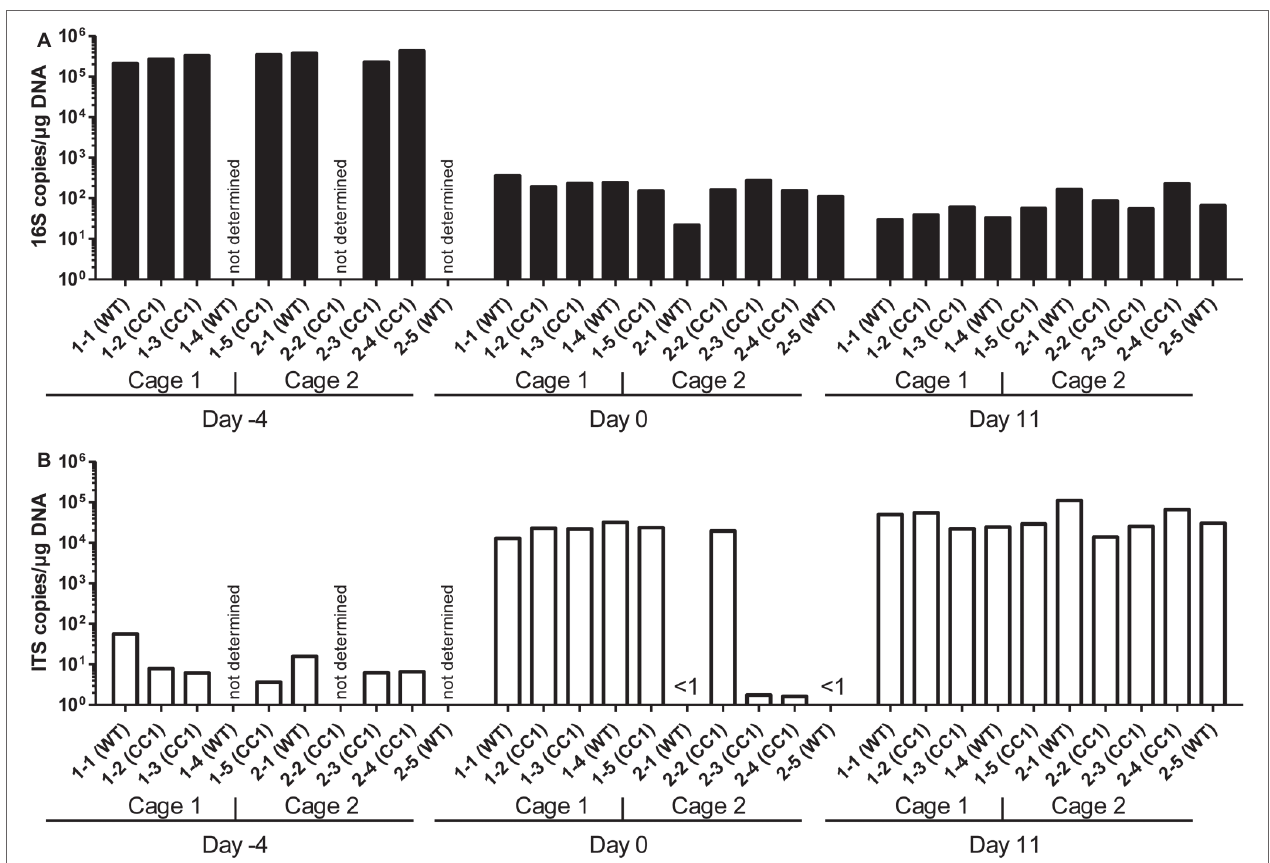
FIGURE 1 | Influence of antibiosis and intestinal colonization by C. albicans on the relative abundance of bacteria and fungi. Human CEACAM1-transgenic mice (CC1, N = 5) and their wild-type littermates (WT, N = 5), co-housed in two cages, were treated with antibiotics from day − 4 and inoculated with 5 × 10 7 CFU C. albicans orally at day 0 (see also Table 1 ). Feces were collected from individual mice on day − 4 (untreated/before antibiotic treatment), day 0 (4 days of antibiosis/ before C. albicans inoculation), and day 11 (11 days of C. albicans inoculation, continuous antibiosis). DNA was extracted and analyzed by qPCR for copy numbers of bacterial 16S DNA (A) and fungal ITS DNA (B) . Copies per μ g DNA were calculated by standards included in the qPCR runs. Note that for three samples (labeled as “not determined”) not enough feces was left for this analysis since the samples were necessary to determine the primary effect size (fungal colonization) shown in Figure 3A . All data are from one single